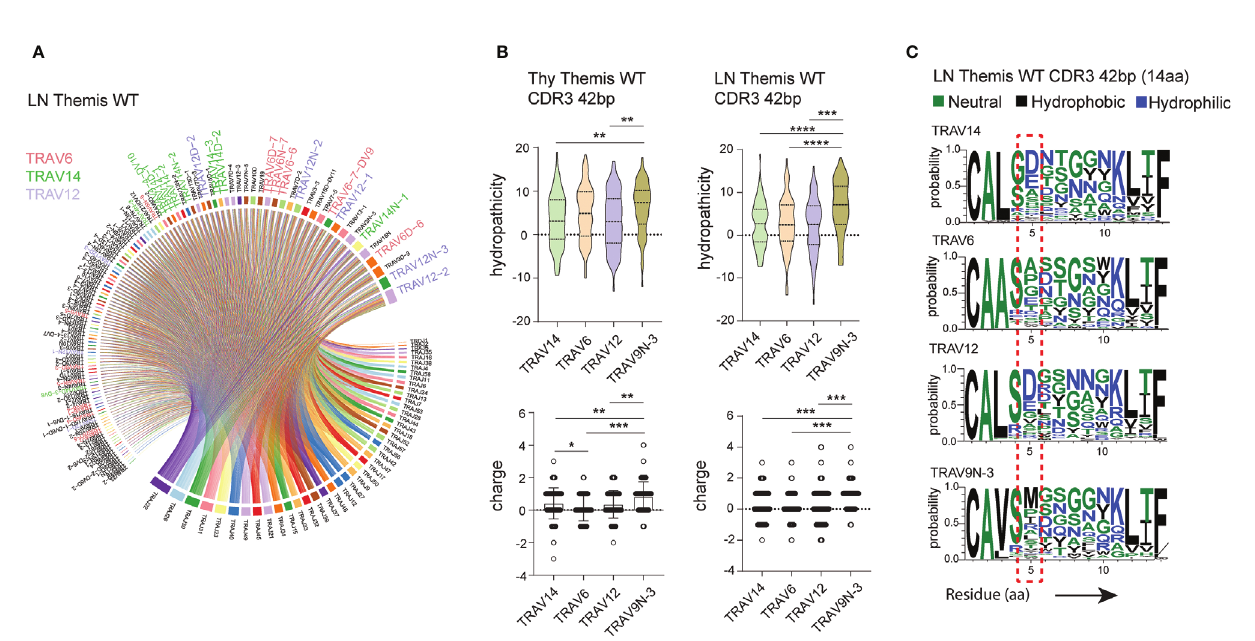
FIGURE 4 | Unique physical features of CDR3 of V a 3.2 + CD8 + T cells. (A) V a and J a segment usage in the peripheral CD8 + TCR a repertoire. TRAV12, TRAV6, and TRAV14 segments are highlighted: lavender, plum, and green, respectively. (B) Hydrophobicity (upper panel) and charge (lower panel) of the CDR3 regions from V a 3.2 (TRAV9N-3) and a representative fraction of non-V a 3.2 receptors. Each V a -associated group is represented by the 100 most dominant clonotypes from 14 amino acid-long CDR3 compartment. (C) Distribution of the amino acids within CDR3 regions. *p < 0.05, **p < 0.01, ***p < 0.001, ****p < 0.0001 as determined by two-sided Student ’ s t-test with Welch ’ s